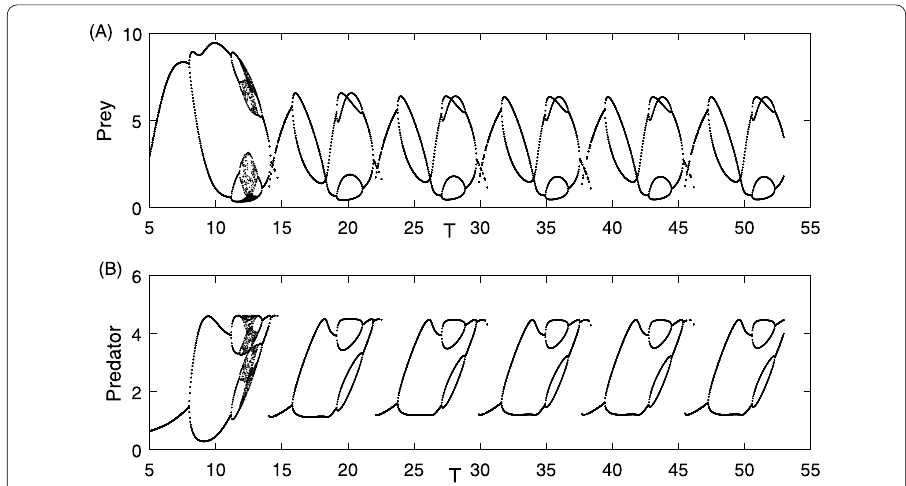
Figure 1 Bifurcation diagrams of model (17) with respect to bifurcation parameter T . Parameter values are: r = 2.79, k = 10, α = 1.2, c = 0.37, ω = 0.25, D = 0.59, δ = 0.69, h = 0.27, λ 1 = 1.25, λ 2 = 5.2, θ =